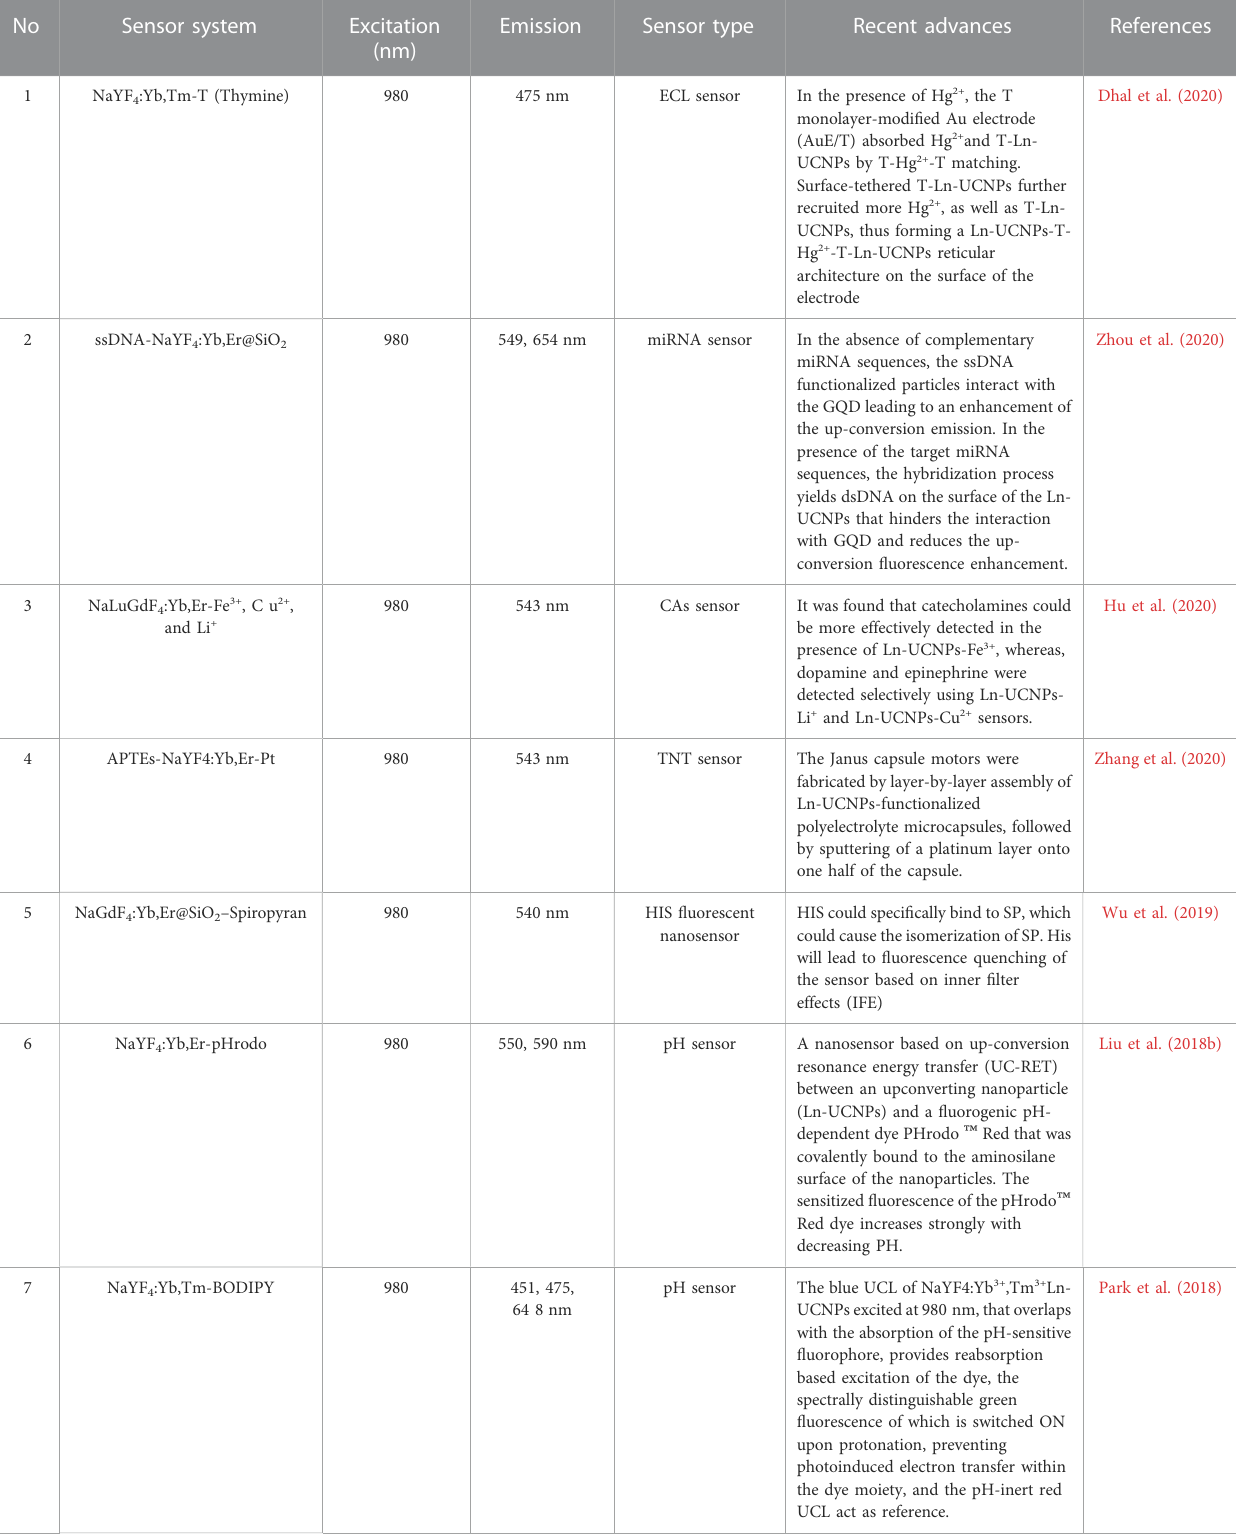
TABLE 2 Typical cases of Ln-UCNPs for